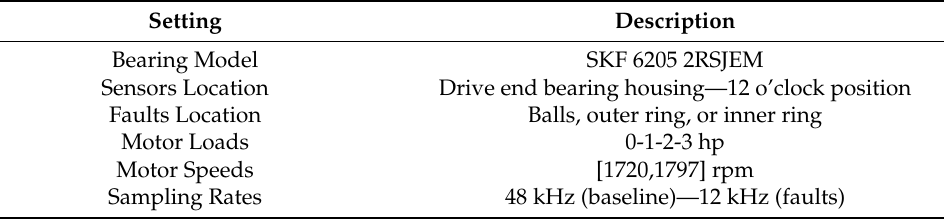
Figure 3. CWR experiment setup. Based on [72]. Table 1. CWR experiment settings.